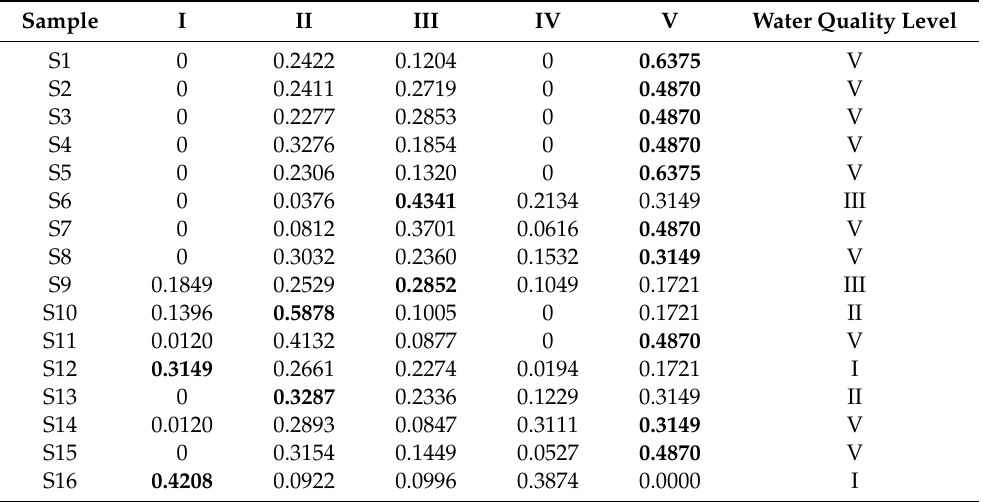
Table 3. Fuzzy comprehensive evaluation results of the Taiyuan formation limestone water quality in the study